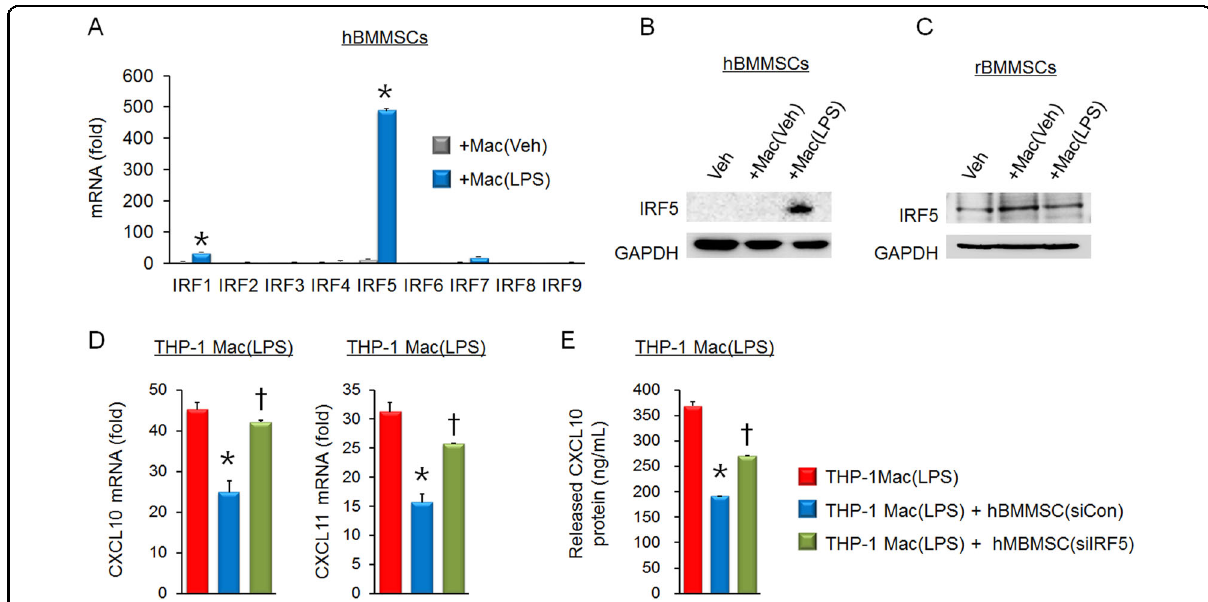
Fig. 6 IRF5 is essential in BMCs and exerts an anti-in fl ammatory effect on LPS-stimulated macrophages. a mRNA expression patterns of IRF family members were examined in hBMMSCs after coculture with THP-1-derived macrophages stimulated with vehicle or LPS. b IRF5 protein expression was upregulated in hBMMSCs cocultured with LPS-stimulated macrophages. c IRF5 protein expression also increased in rBMMSCs cocultured with rBMDMs. d LPS-induced upregulation of the proin fl ammatory markers CXCL10 and CXCL11 was apparently inhibited by coculture with hBMMSCs transfected with the siRNA control. Conversely, coculture with hBMMSCs transfected with the IRF5 siRNA failed to attenuate the upregulation of CXCL10 and CXCL11. e CXCL10 protein expression was measured in media from THP-1-differentiated macrophages cocultured with hBMMSCs transfected with the siRNA control or IRF5